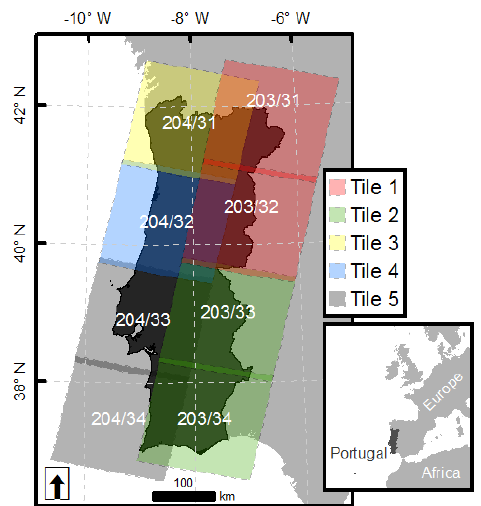
Figure 1. Continental Portugal and corresponding Landsat path/rows. Colors indicate merged path/rows to define five tiles used in image processing and classification.